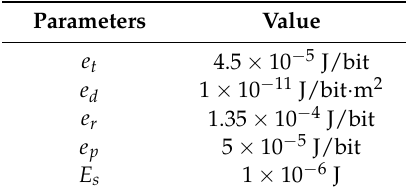
Table 1. Parameters in the energy consumption model.